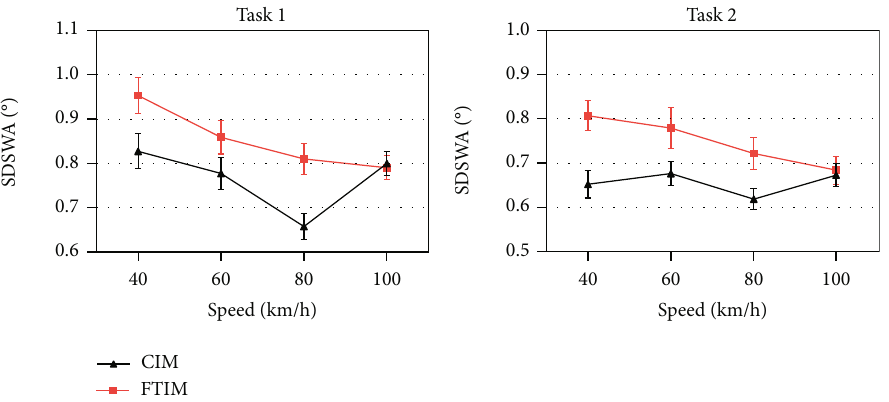
SDSWATLCSDLPPoLDGMSGDNoGPoGTCT